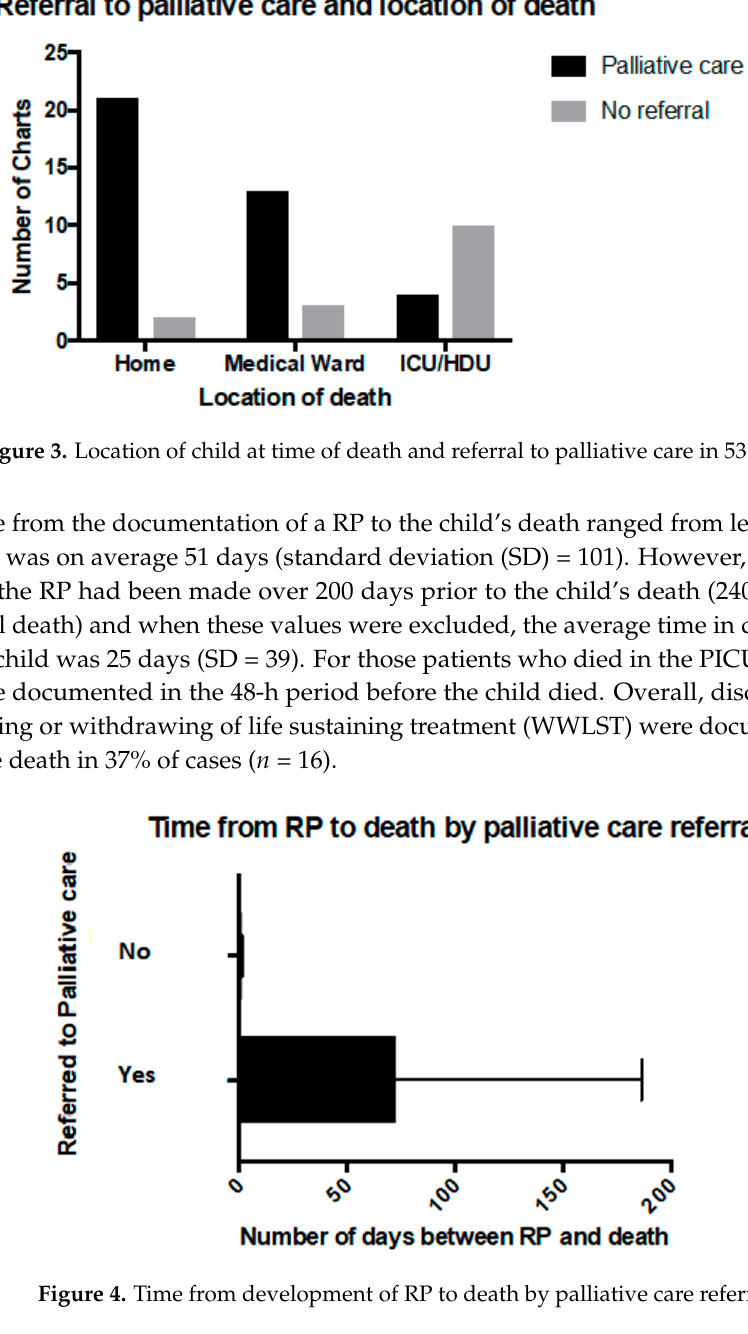
Figure 5. Location of RP. 4. Discussion 4.1. Shared Decision-Making Some clinicians working within paediatric palliative care argue that a focus on RPs is of limited value [16]. There are significant other components to paediatric palliative care (such as symptom management, practical and emotional support) and appropriate spiritual or cultural care that go beyond resuscitation planning. Further, it is argued that the documentation does not truly capture the series of sensitive conversations that may be required for a child and family to experience a dignified death. Nevertheless, a documented RP is a clinical indicator of an important example of shared decision-making related to a very sensitive and difficult aspect of clinical care. C u rr e n t a d m i s s i o n